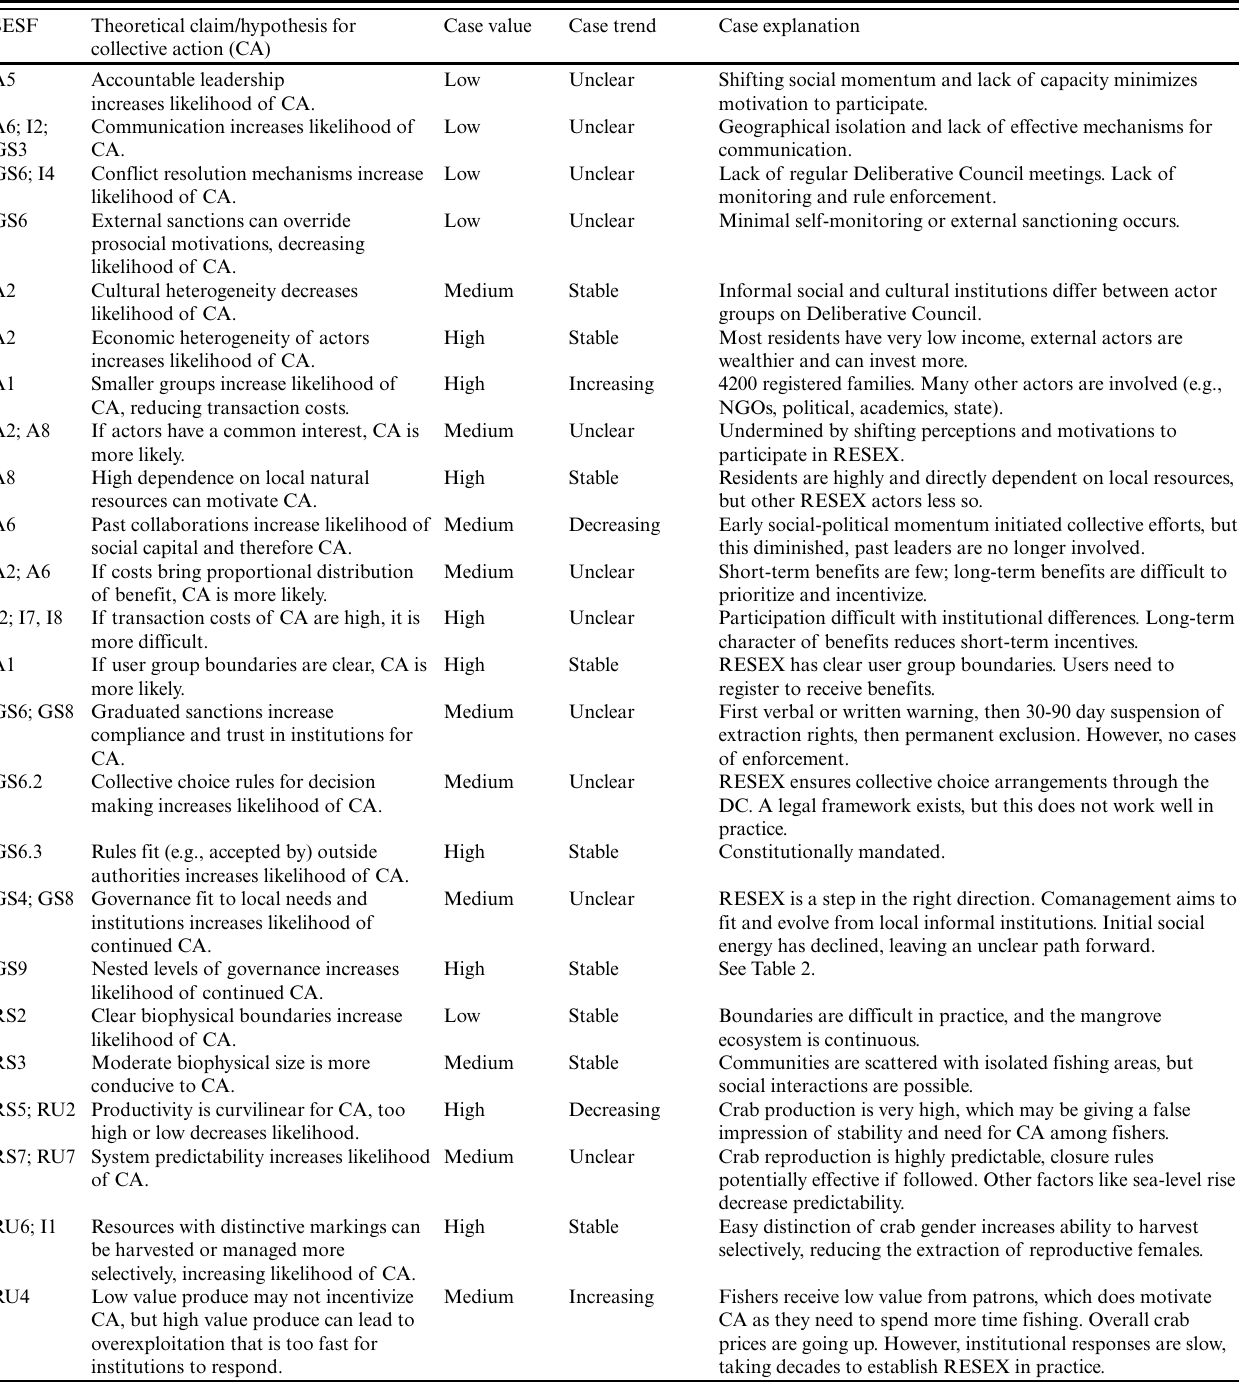
Table 3 . Social-ecological systems framework (SESF) second-tier variables and their case value in the Caeté-Taperaçu (CT) RESEX associated with hypotheses of collective action theory (Ostrom 1990, Poteete et al. 2010, Cox 2014). A general trend is shown for current case values, and a brief contextual explanation. RESEX = marine extractive